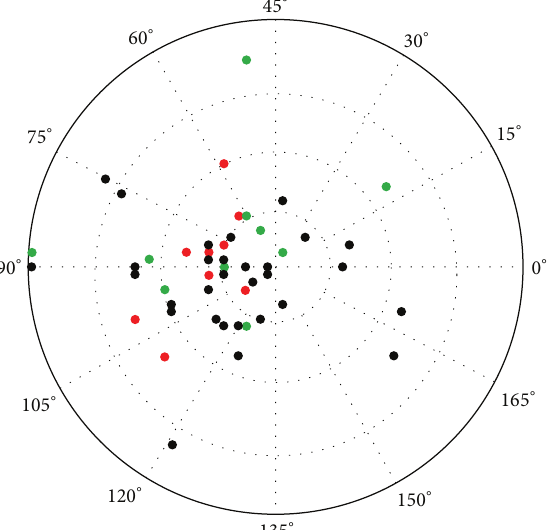
Figure 3: Postoperative astigmatism. Green dots: eyes with iris/IOL complications and abnormalities; red dots: eyes with deceleration of CDVA.